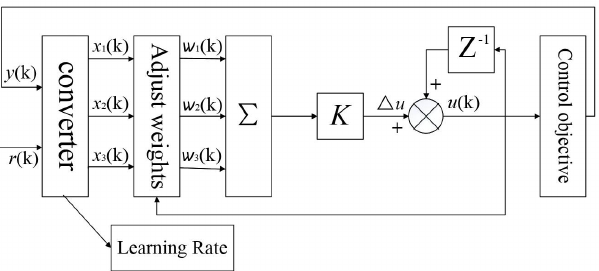
Figure 8. Structure of the single neuron adaptive PID. Note: k is the current time; r ( k ) is the input variable of the controller at time k ; y ( k ) is the output variable of the controller at time k ; x 1 ( k ) is the neuron recording the change of error at time k ; x 2 ( k ) is the neuron recording the change of error at time k − 1; x 3 ( k ) is the neuron recording the change of error at time k − 2; ω 1 ( k ) is the learning rule of neuron x 1 ( k ); ω 2 ( k ) is the learning rule of neuron x 2 ( k ); ω 3 ( k ) is the learning rule of neuron x 3 ( k ); K is the proportional coefficient of the neuron adaptive PID; u ( k ) is the output signal of the single-neuron adaptive PID controller at time k .